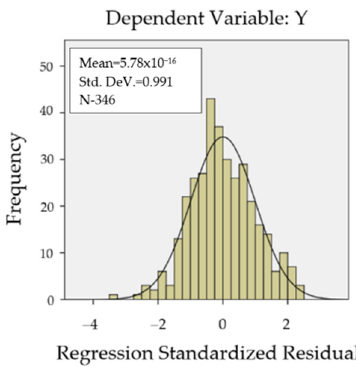
Figure 8. Histogram. Figure 8.